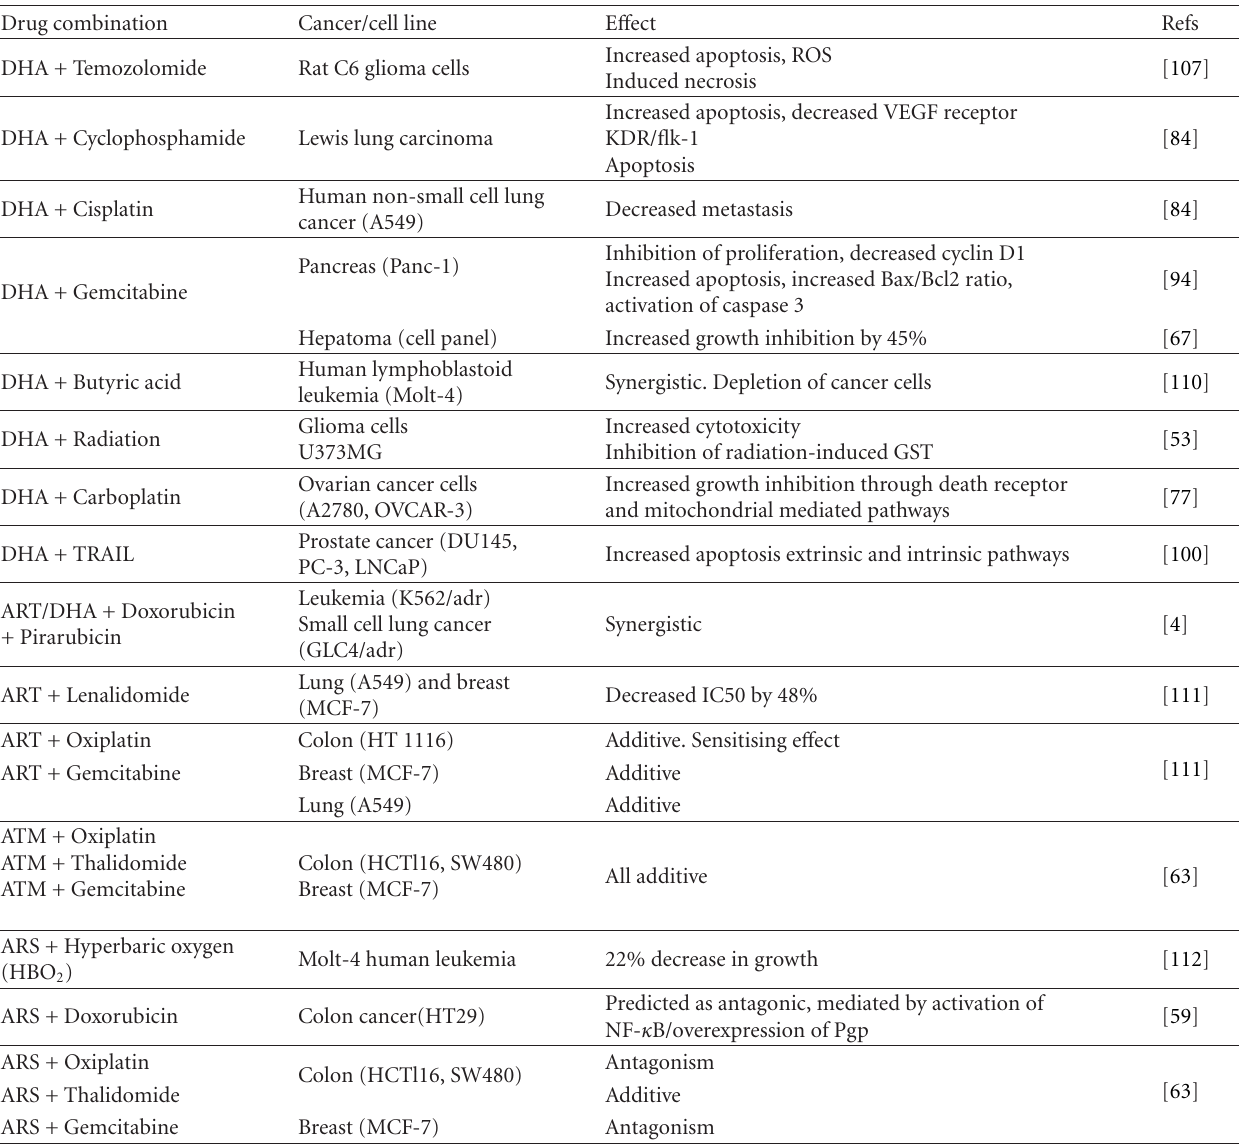
Table 3: Drug interactions of